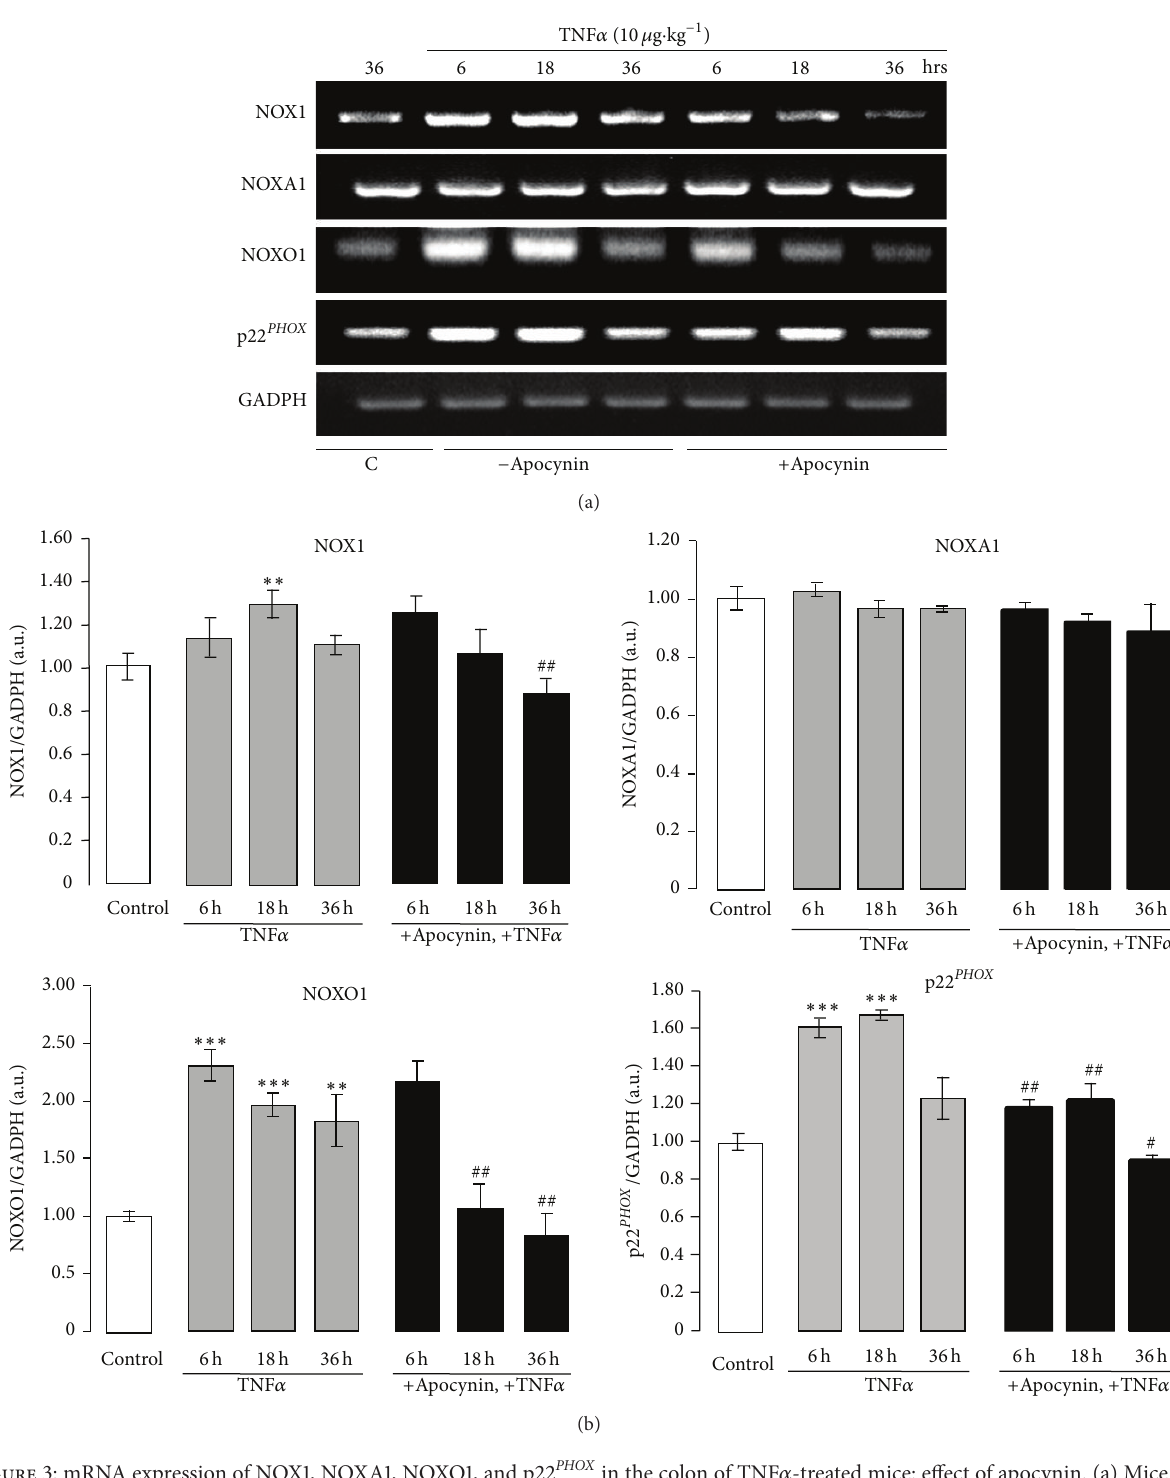
Figure 3: mRNA expression of NOX1, NOXA1, NOXO1, and p22 PHOX in the colon of TNF 𝛼 -treated mice: effect of apocynin. (a) Mice were treated with TNF 𝛼 (10 𝜇 g ⋅ kg −1 , ip) in the presence or absence of apocynin (25mg ⋅ kg −1 , ip) as described in Figure 1(a) (C in the figure is for control untreated mice). Total RNA from colons was extracted and RT-PCR was performed as described in Section 2 using NOX1, NOXA1, NOXO1, or p22 PHOX gene-specific primers. Mice GADPH served as an internal control; (b) densitometric analysis of the ratio of NOX1, NOXA1, NOXO1, or p22 PHOX mRNA expression to the total amount of GADPH mRNA. Data are expressed as means ± S.E.M from 𝑛 = 5 mice in each group. ∗ 𝑃 < 0.05 , ∗∗ 𝑃 < 0.01 , and ∗∗∗ 𝑃 < 0.001 versus control; # 𝑃 < 0.05 , ## 𝑃 < 0.01 , and ### 𝑃 < 0.001 versus TNF 𝛼